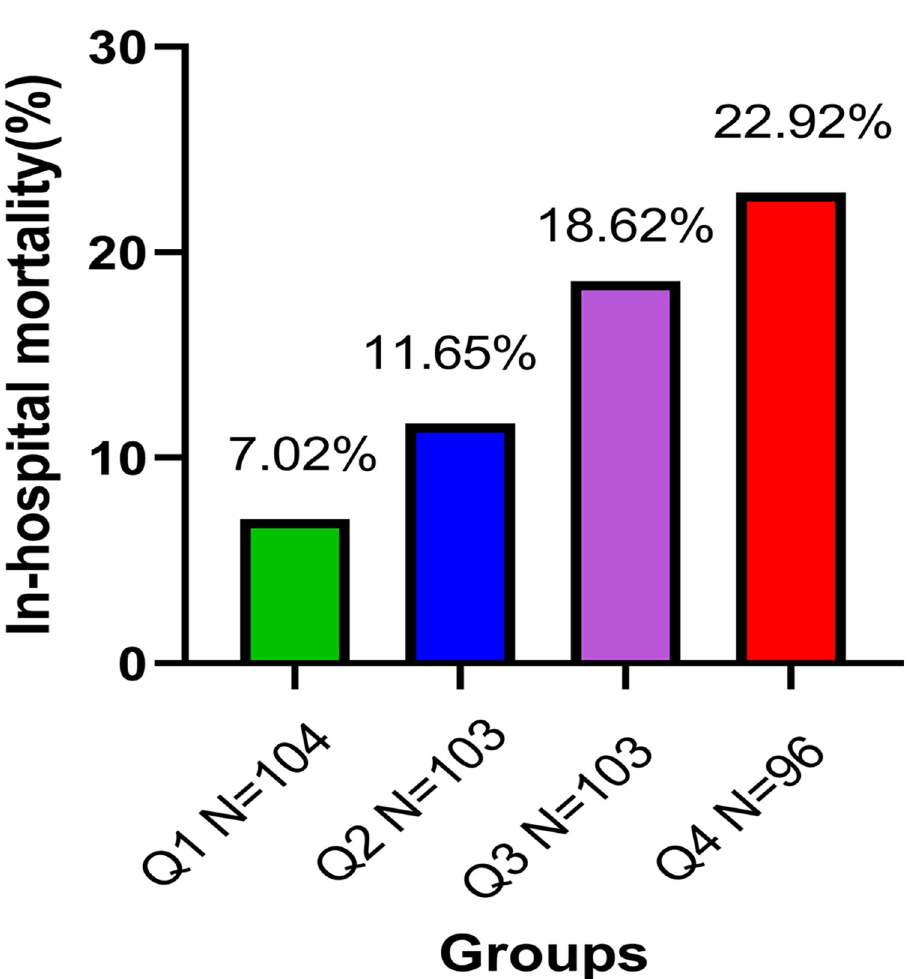
Table 3. Relationship between serum sodium and in-hospital mortality in different models of serum sodium quartiles.